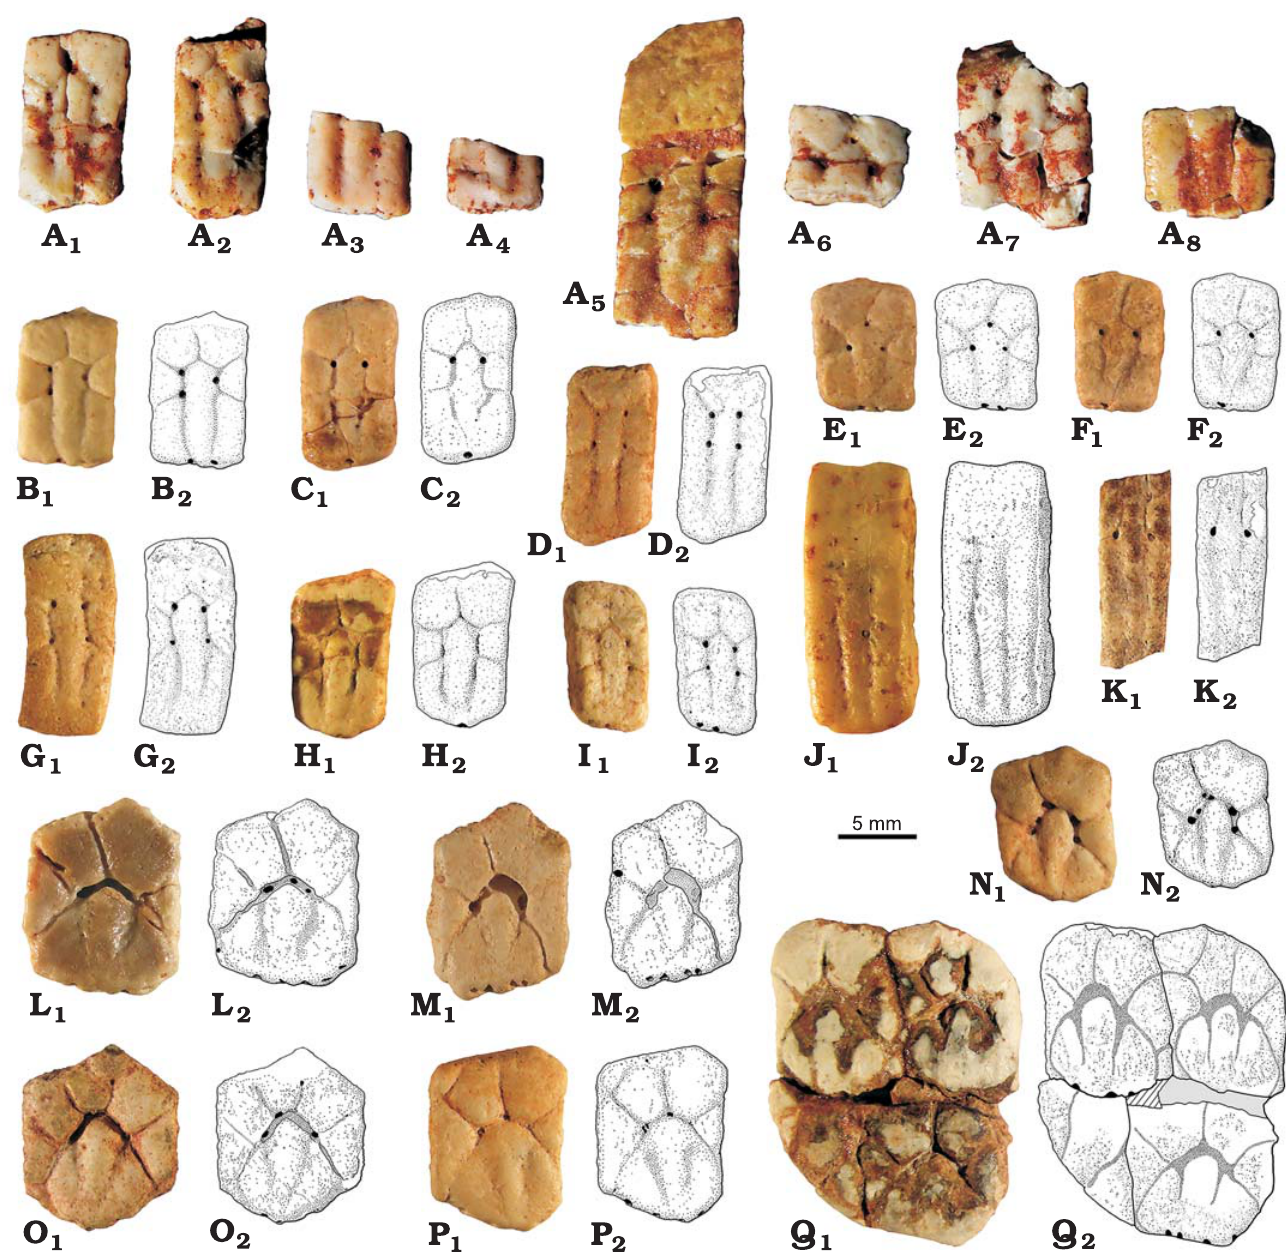
Fig. 5. Osteoderms of euphractin Parutaetus punaensis sp. nov. from the middle member of the Geste Formation, middle–late Eocene, Northwestern Argentina. A . Holotype, MLP 83-XI-3-2; Quebrada El Paso, near the Pozuelos salt flat, Los Andes Department, Salta Province. B–E . Fixed osteoderms from Antofagasta de la Sierra, Catamarca Province; morphotype assigned to the lateral zones of the pelvic buckler, MLP 93-VI-1-17 ( B , D ), MLP 86-V-6- 25 ( C , E , F–I ), and movable osteoderms, MLP 86-V-10-19 ( J ), MLP 93-VI-1-18 ( K ). L – Q . Fixed osteoderms from Antofagasta de la Sierra, Catamarca Province; morphotype assigned to the medial zone of the pelvic buckler, MLP 88-V-10-18 ( L ), MLP 86-V-6-24 ( M – P ), MLP 86-V-6-25 ( Q ). Photographs (A, B 1 − Q 1 ), line drawings (B 2 − Q 2